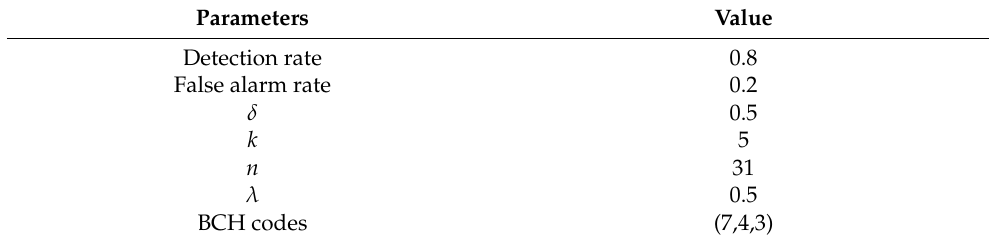
Table 3. Parameter